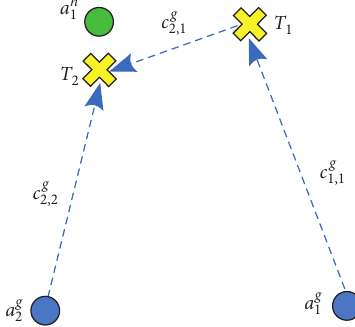
Figure 4: An example explaining the necessity of multitasking capability of gatherer